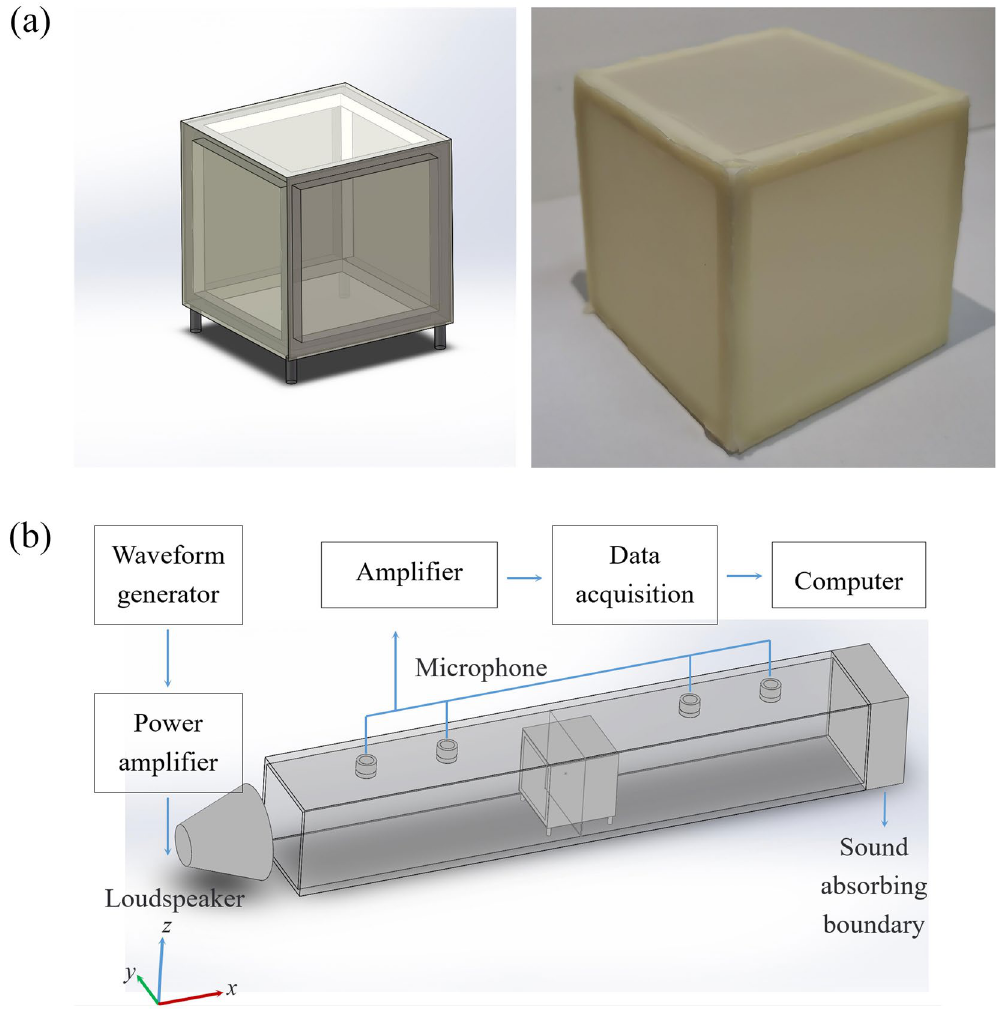
Figure 1. Experimental apparatus. ( a ) The model (left) and photo (right) of a MFCB. ( b ) Experimental apparatus for measuring the transmission loss induced by the MFCB. The distance between the adjacent microphones at the input end (or output end) is 15 cm s 1 = s 2 = 15 cm and the distance between the microphone 2 (or 3) to the MFCB is 45 cm l 1 = l 2 = 45 cm (the figure is created using SOLIDWORKS